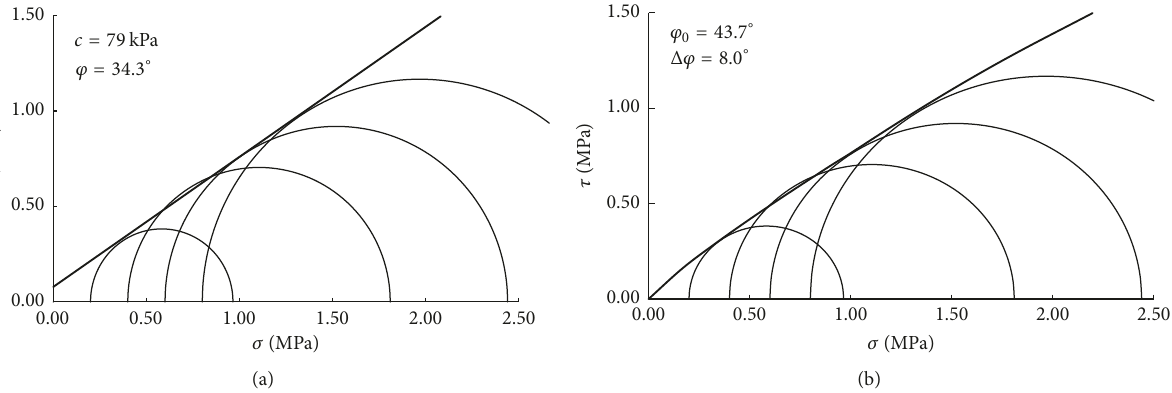
Figure 8: Shear strength envelope of the 40-year cemented mercury slag.